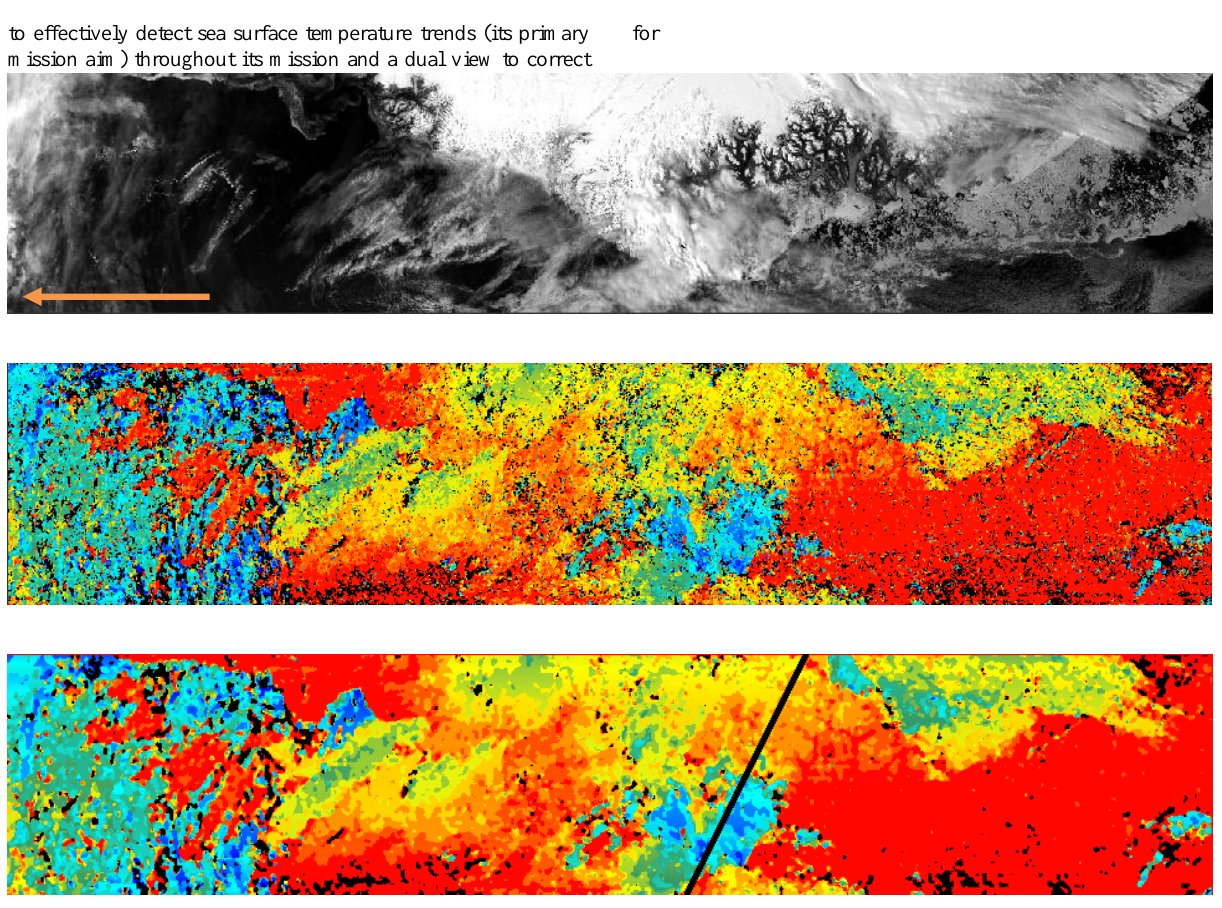
Figure 1 (a-c). The top image (Figure 1a.) is the 0.55um nadir view from AATSR orbit 33086 (28 th June 2008). The image is of the Eastern coast of Greenland, the orange arrow represents the direction of motion. The middle image (Figure 1b.) is the raw CTH output from the Census stereo matching between the nadir and forward views, with red denoting the height at sea-level and blue and dark blue a value of around 8km. The bottom image (Figure 1c.) is the CTH after application of a 5x5 median filter. The black transect passing through the image is the path of the CALIOP overpass used for the